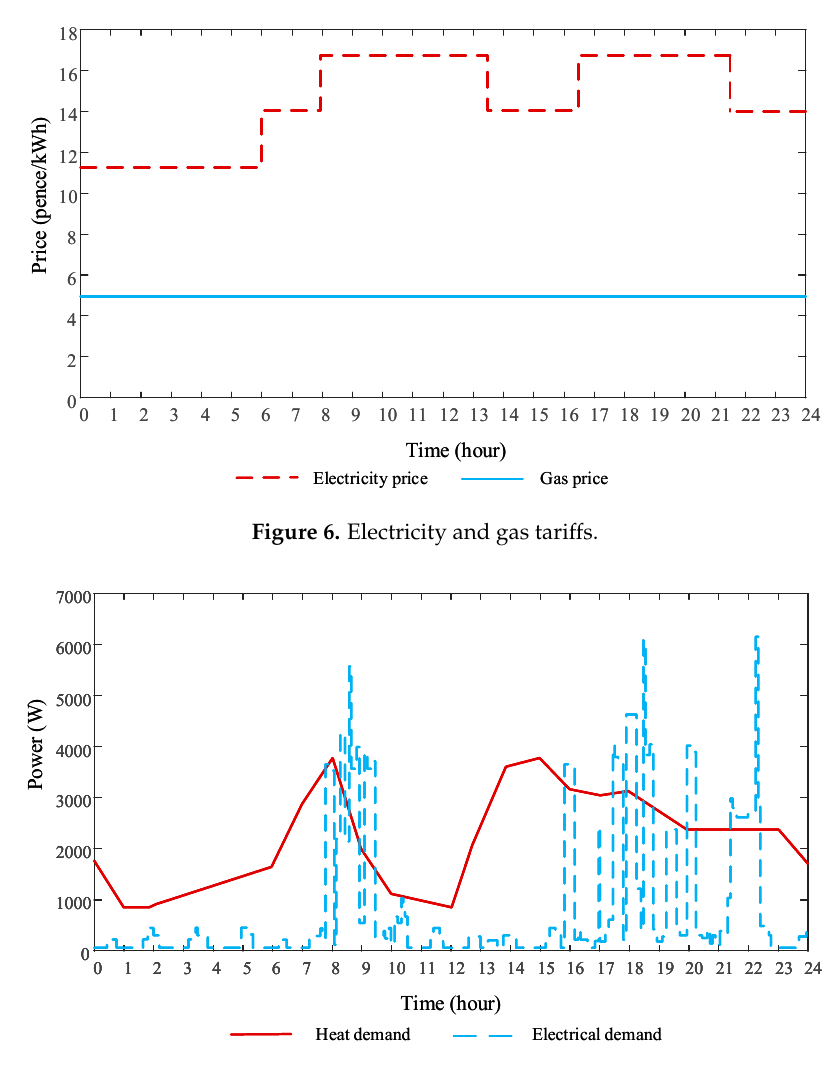
Figure 7. An example of daily heat demand and Electrical Demand.